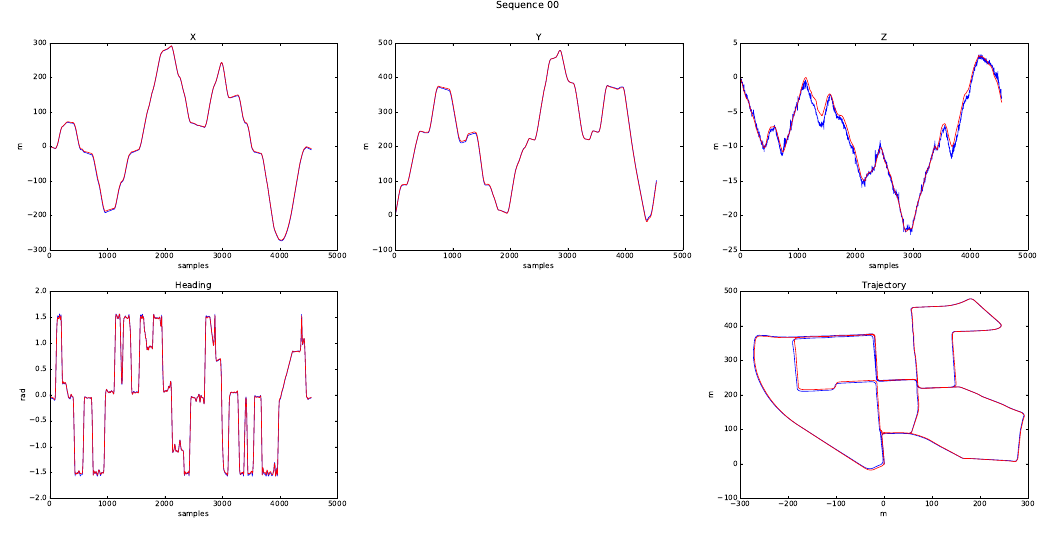
Figure 20. Sequence 00